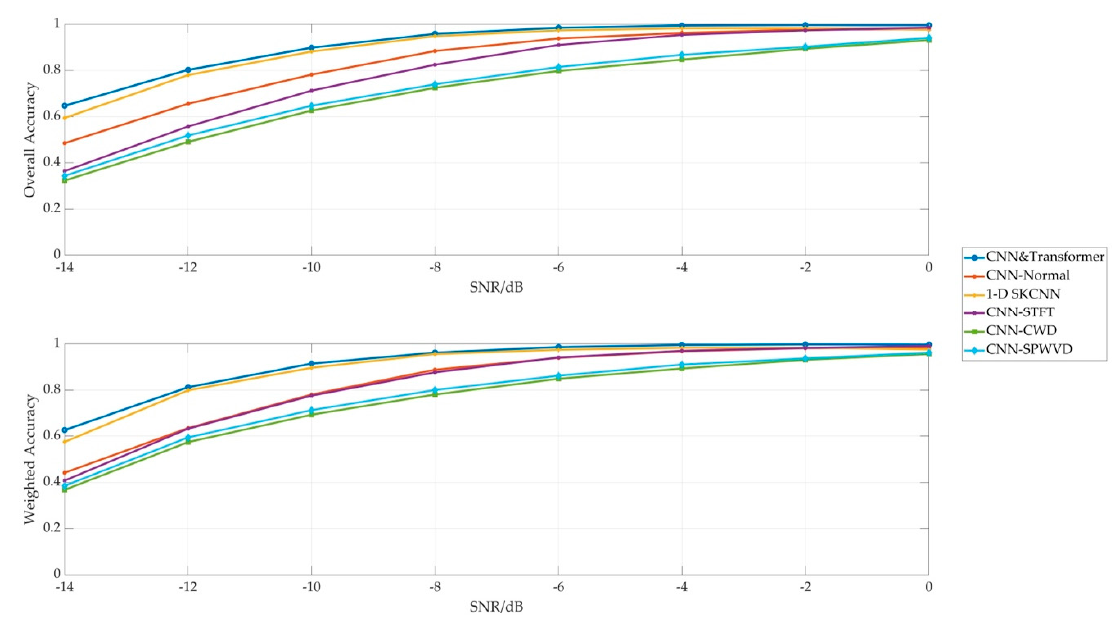
Figure 8. The overall classification accuracy and weighted classification accuracy of the methods based on different SNR.